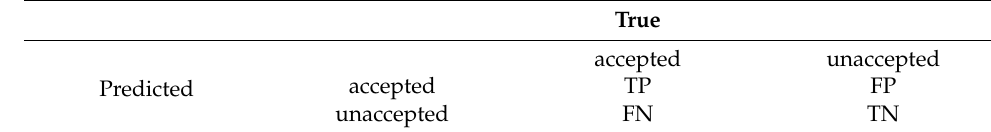
Table 1. Confusion